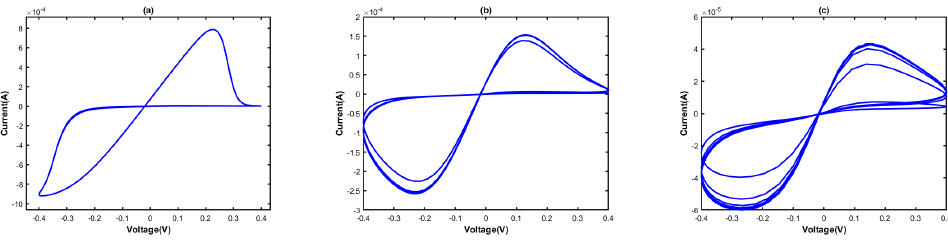
Figure 6. Voltage − current curves for 45 nm, when frequency is ( a ) 2 kHz, ( b ) 10 kHz, and ( c ) 20